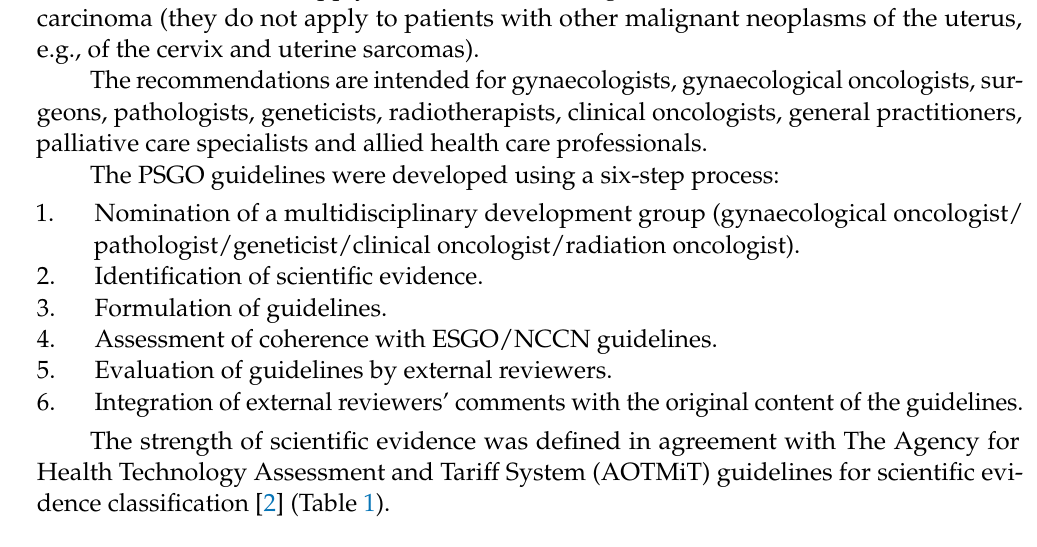
Table 1. Grading criteria according to The Agency for Health Technology Assessment and Tariff System (AOTMiT)